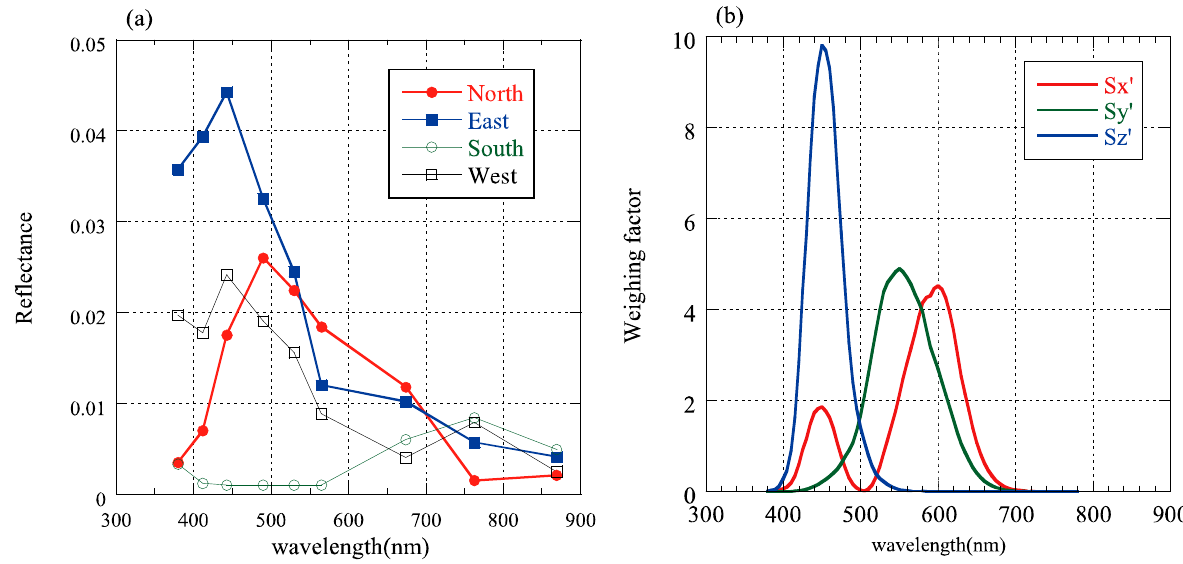
Figure 3. ( a ) Samples of GCOM-C atmospheric corrected spectral reflectance data, 12–20 August 2020, and ( b ) and weighting function of the CIE 1931.